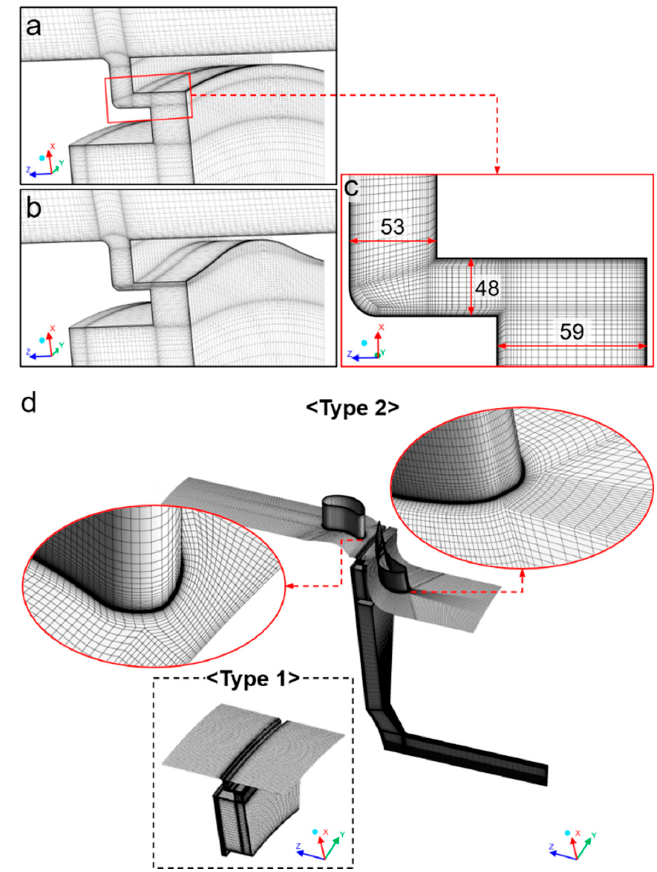
Figure 3. Computational grid. Grid for wheelspace of: ( a ) Type 1 C and ( b ) Type 1 W; ( c )